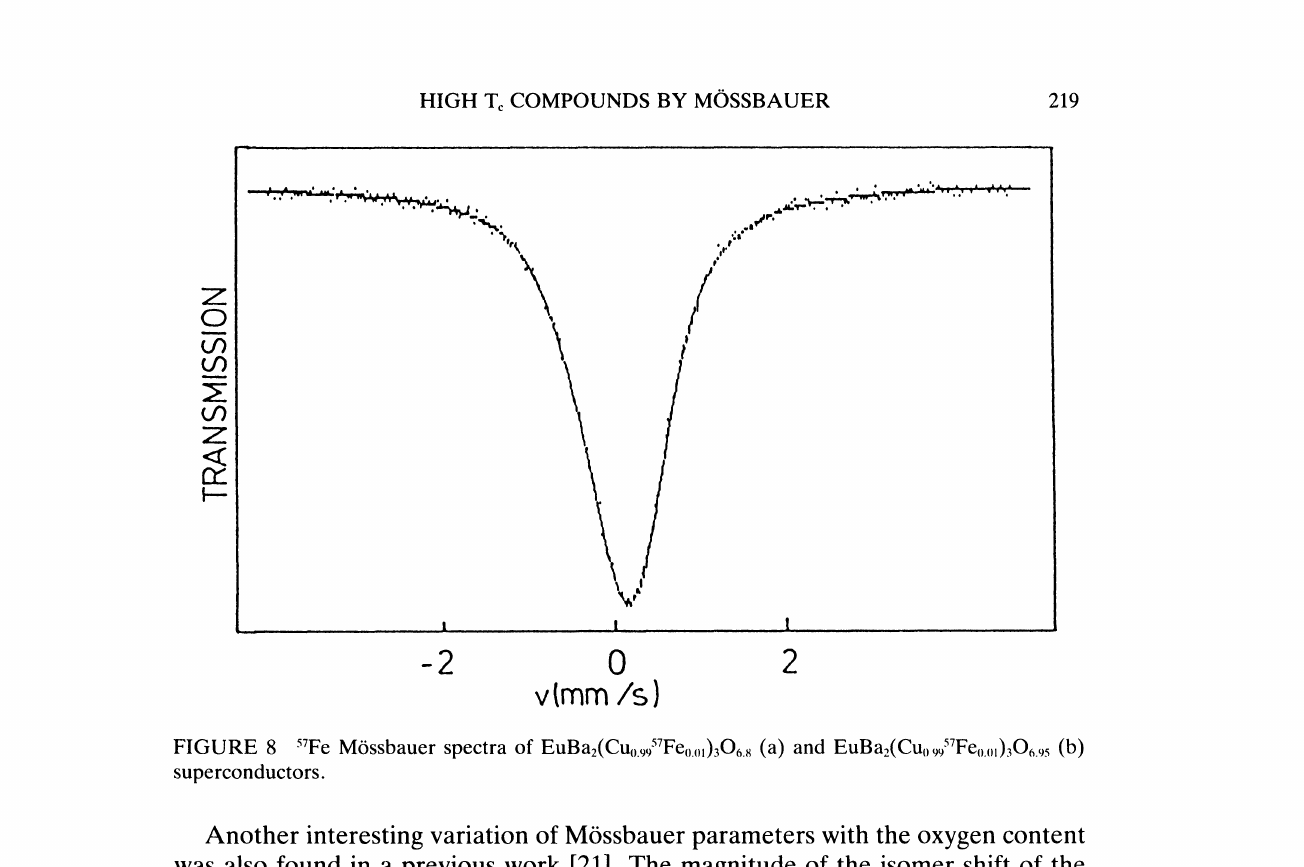
FIGURE 8 5TFe M6ssbauer spectra of EuBa2(fu0.9957Fe0.01)306.8 (a) and EuBa2(Cu09957Fe0.m)306.95 (b)